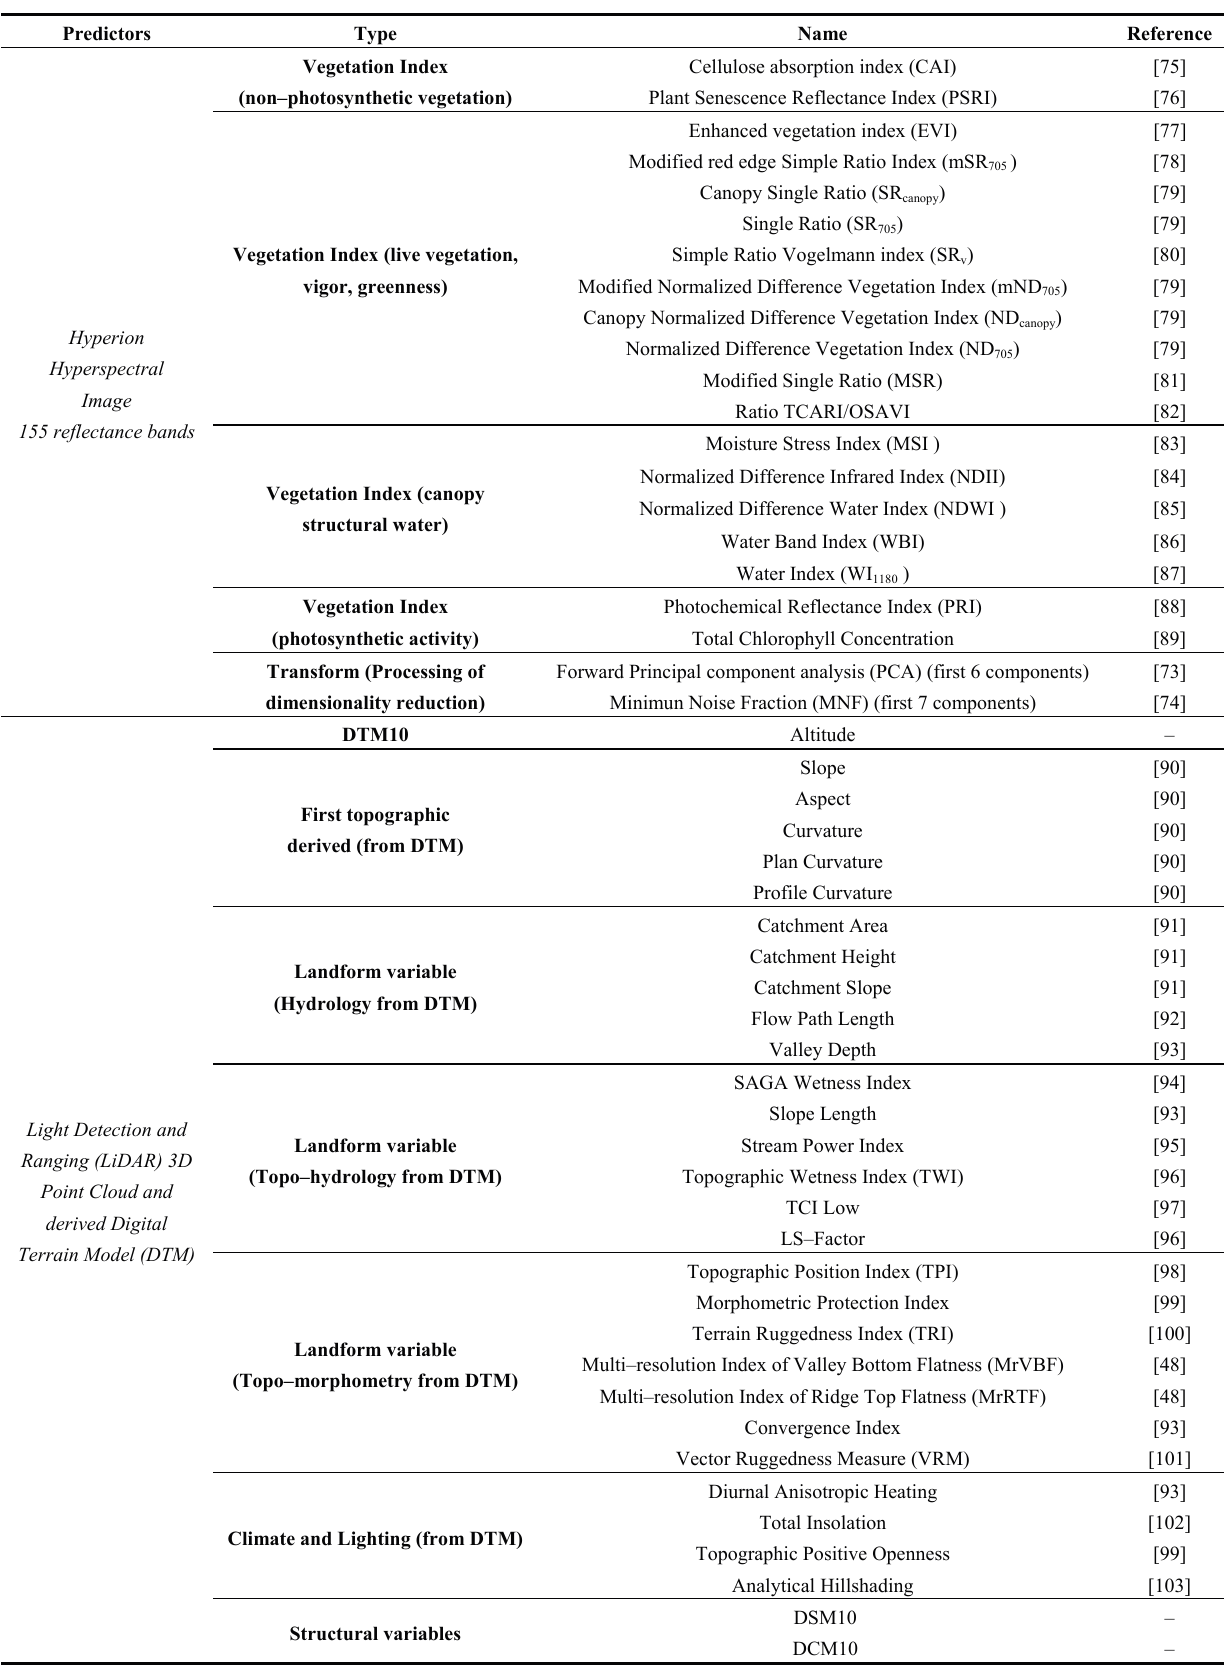
Table 2. Summary of predictor variables (hyperspectral and Light Detection and Ranging (LiDAR)) used to generate the predictive model of